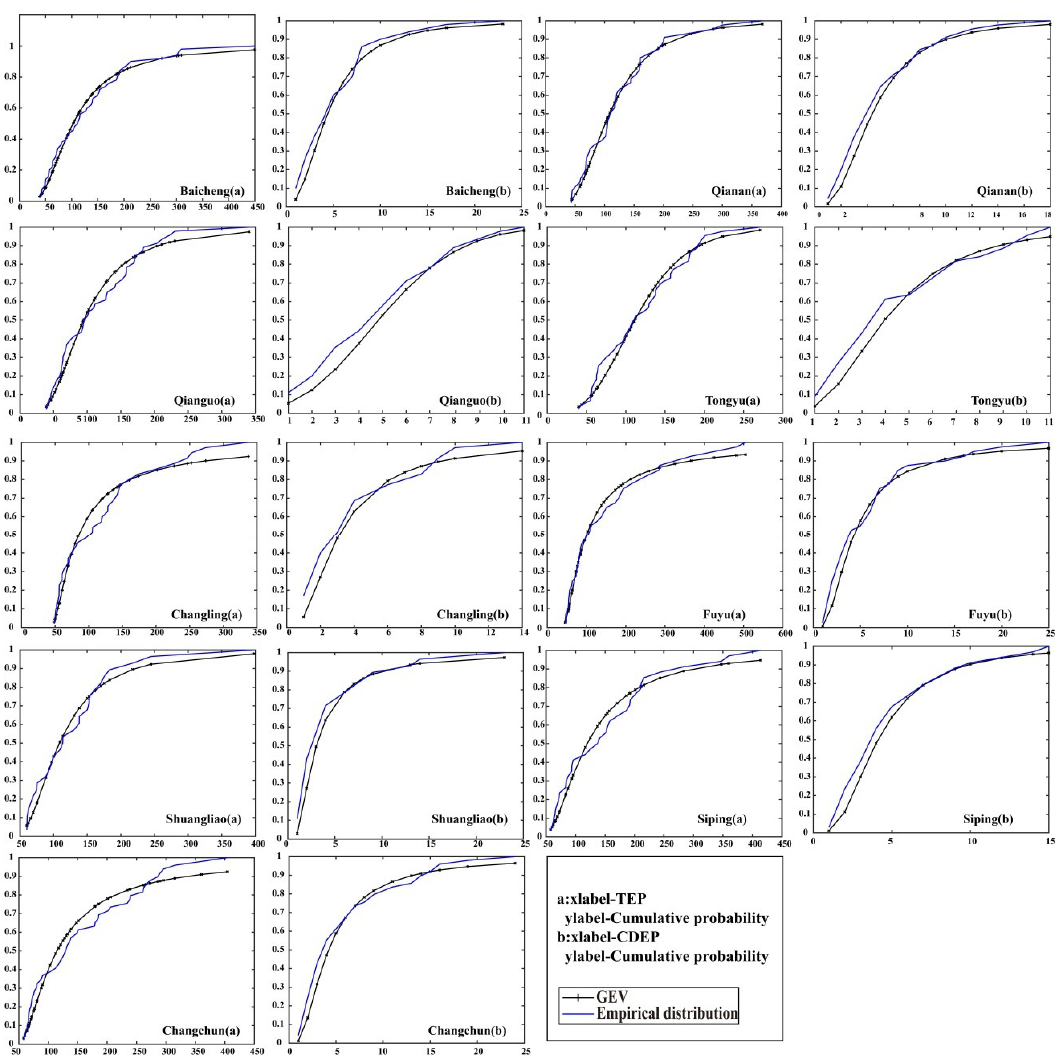
Figure 4. Comparison of the observed samples and the fitted marginal distributions of CDEP and TEP.